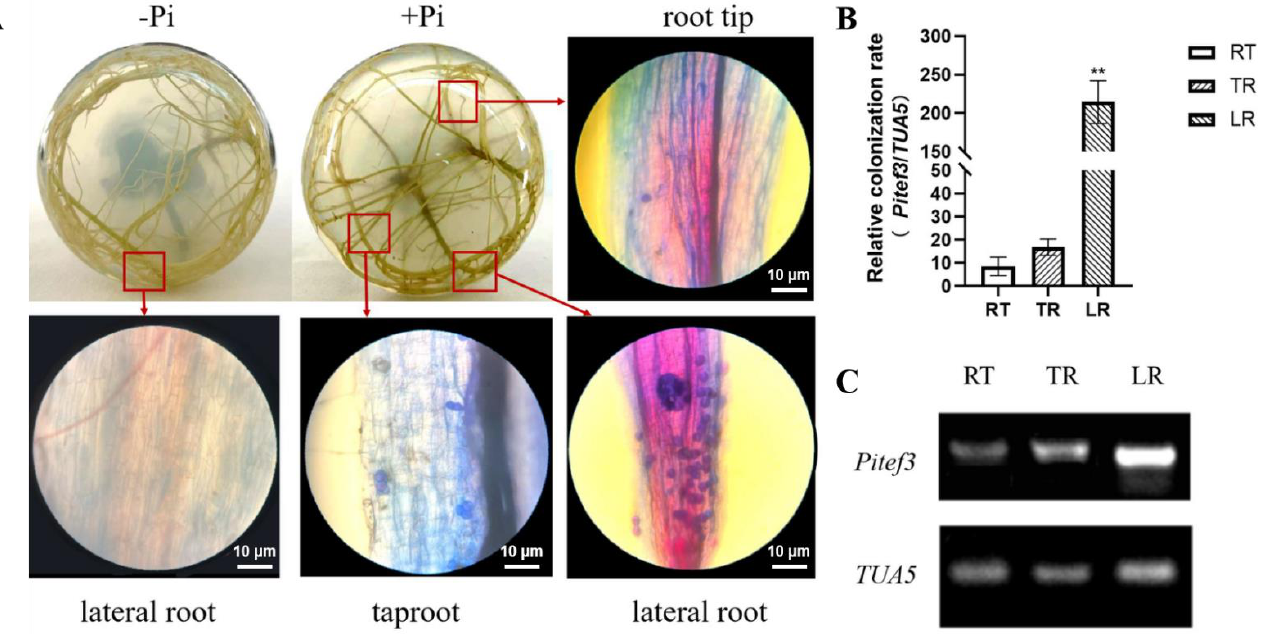
Figure 2. Differences in the colonization and distribution of Piriformis indica in the lateral roots, taproots, and root tips of soybean. ( A ) Typical trypan blue detection result of P. indica -colonization in soybean roots (light microscope, magnification 200 × scale, the scale bar indicates 10 µ m). ( B ) The expression of the Pitef1 gene in P. indica -colonized soybean lateral roots (LR), taproots (TR), and root tips (RT) by qRT-PCR and ( C ) RT-PCR. ND: non-detection. +Pi: P. indica -colonized. −Pi: non-colonized plants. GmTAU5 was an internal reference gene. The values are the means ± SDs of three replicates; ** indicates an extremely significant difference ( p < 0.01).